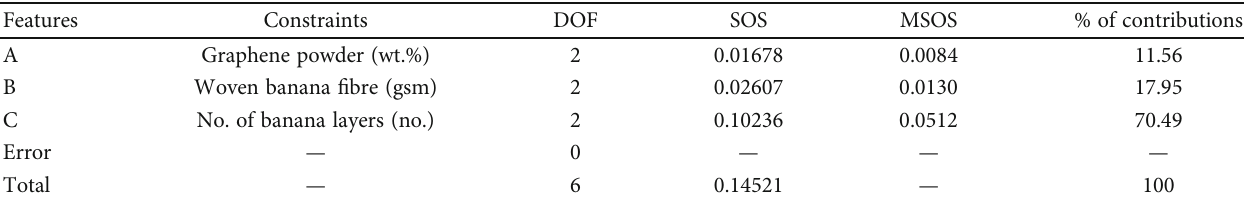
Figure 4: Grey relational grade values of nanocomposites: (a) graphene (wt.%); (b) woven banana (gsm), and (c) number of banana layers (no.). Table 7: ANOVA of